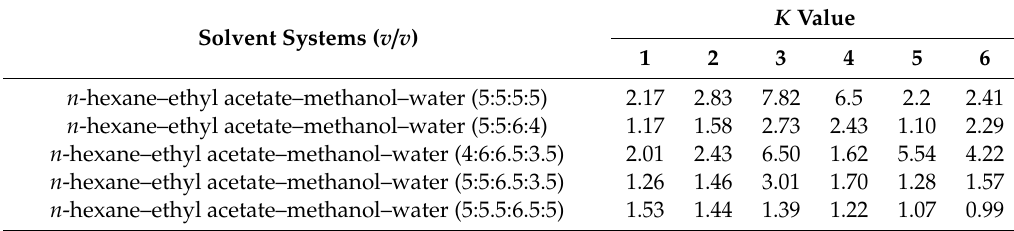
Table 3. The partition coe ffi cient ( K ) of target compounds determined using di ff erent solvent